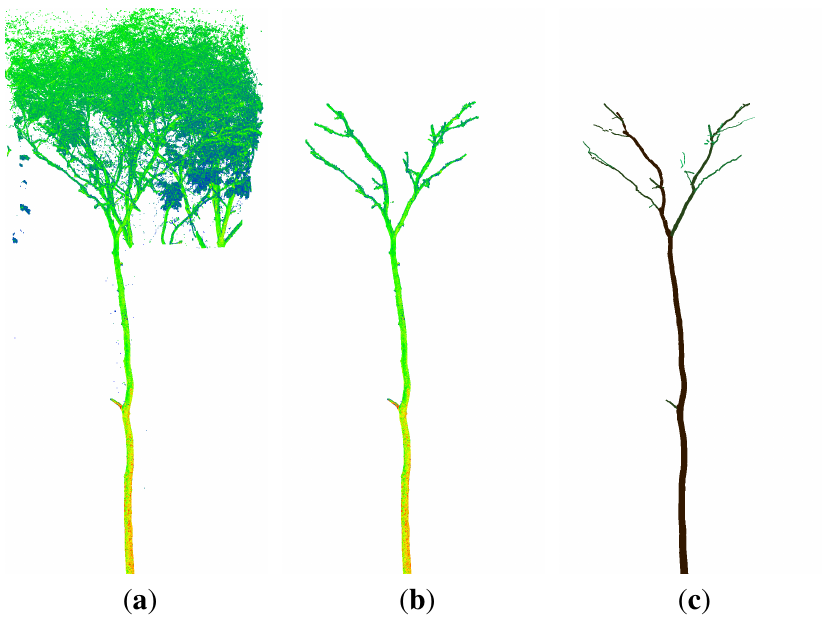
Figure 8. Input and output data of a E. fordii (E#1, height ≈ 14.6 m): (a) input point cloud containing other trees, ghost points and leaf hits; (b) input point cloud after denoising procedures; (c) the resulting cylinder model.